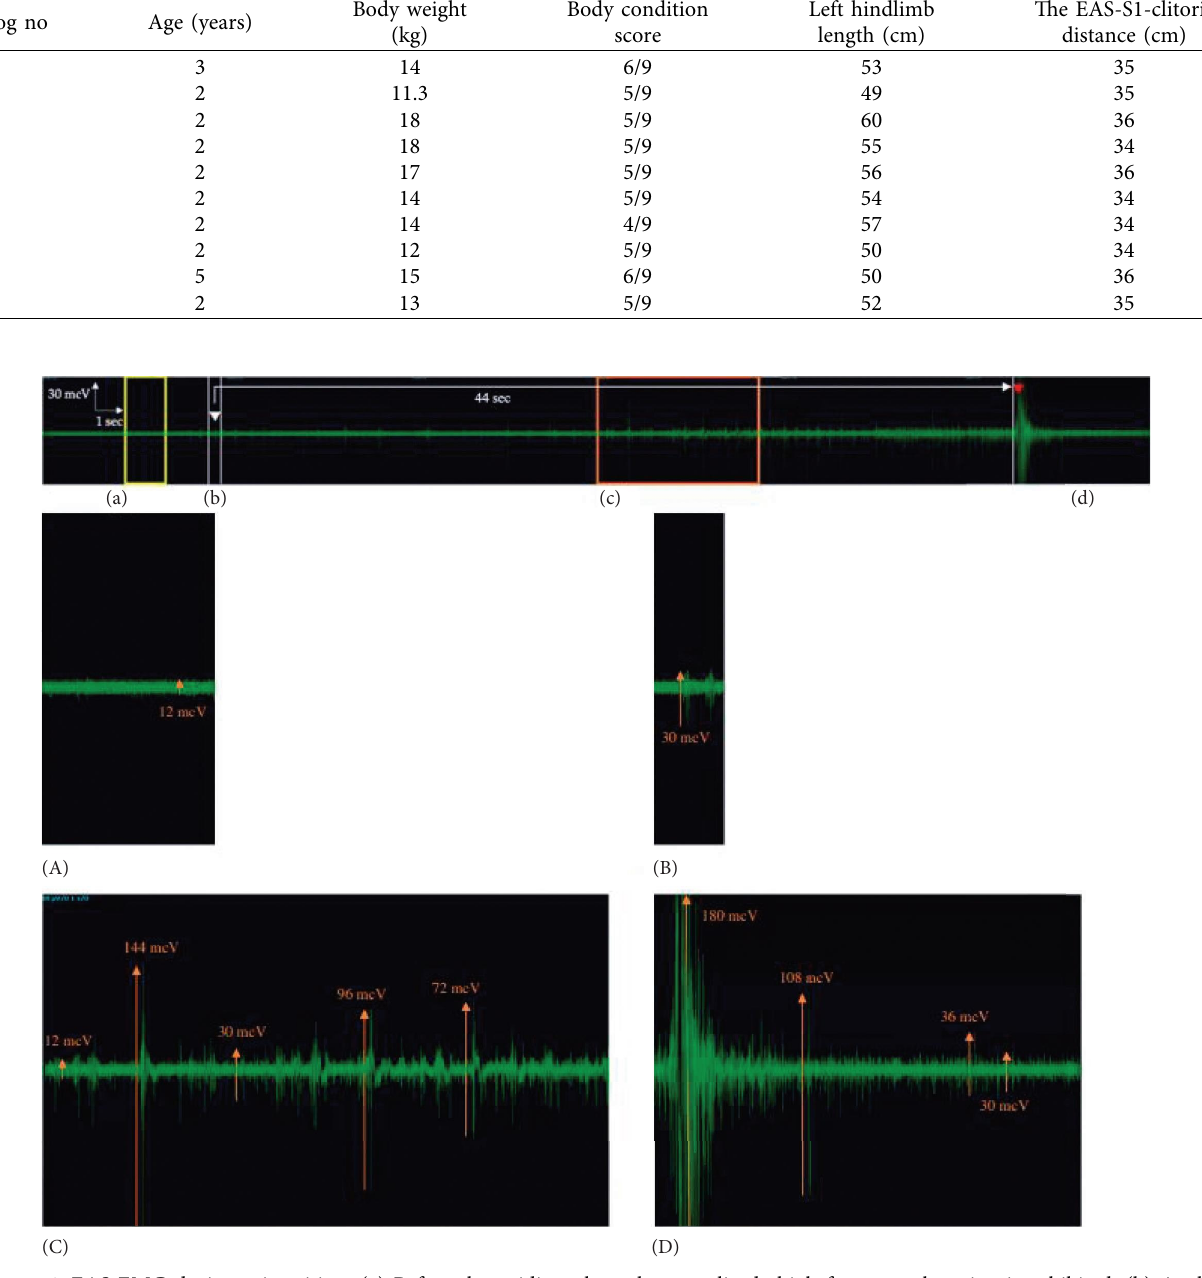
Figure 4: EAS EMG during micturition. (a) Before the voiding phase, low-amplitude high-frequency bursting is exhibited. (b) At the beginning of the voiding phase, medium-amplitude low-frequency bursting is exhibited. (c) During the voiding phase, oscillate medium- and/or high-amplitude low-frequency bursting with low-amplitude high-frequency bursting is exhibited. (d) At the end of the voiding phase, high-amplitude high-frequency bursting (guarding refex) is exhibited. Te white arrow indicates the initial urine leakage and the red arrow indicates the end of urination. EAS, external anal sphincter; EMG, electromyography. (A) Zoomed window of the yellow square from (a) phase; the most prominent pattern is a low-amplitude high-frequency bursting. (B) Zoomed window from the (b) phase, a medium- amplitude low-frequency bursting at the beginning of voiding. (C) Zoomed window of the orange square from (c) phase, oscillating medium- and high-amplitude low-frequency bursting between low-amplitude high-frequency bursting during the pulsatile fow of urine. (D) Zoomed window from (d) phase; the most prominent pattern is a high-amplitude high-frequency